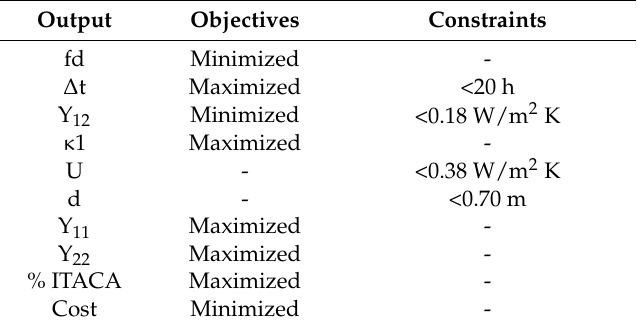
Table 6. Objectives and constraints of the multi-objective optimization